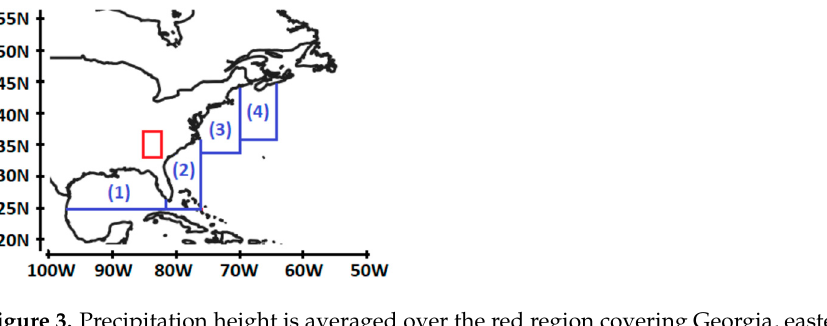
Figure 3. Precipitation height is averaged over the red region covering Georgia, eastern Tennessee, and western North and South Carolina, while SST anomalies are averaged over blue regions 1, 2, 3, and 4, stretching from the Gulf of Mexico to the northeast coast of the United States.